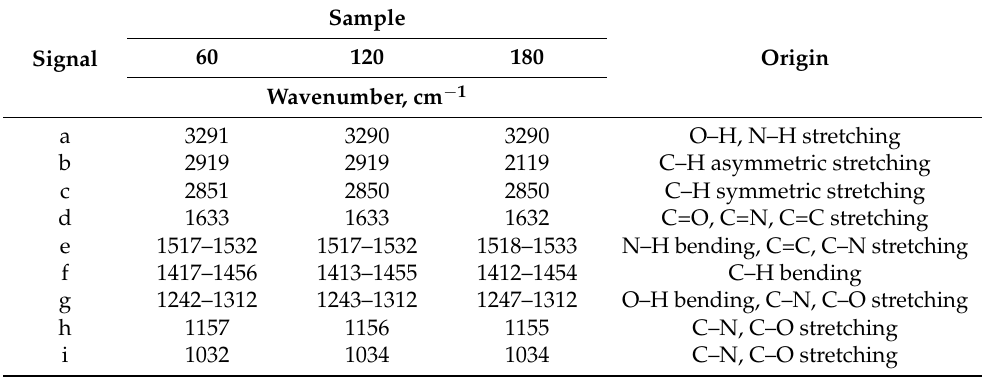
Table 4. Detailed information about the signals observed in the FTIR spectra of analyzed materials.